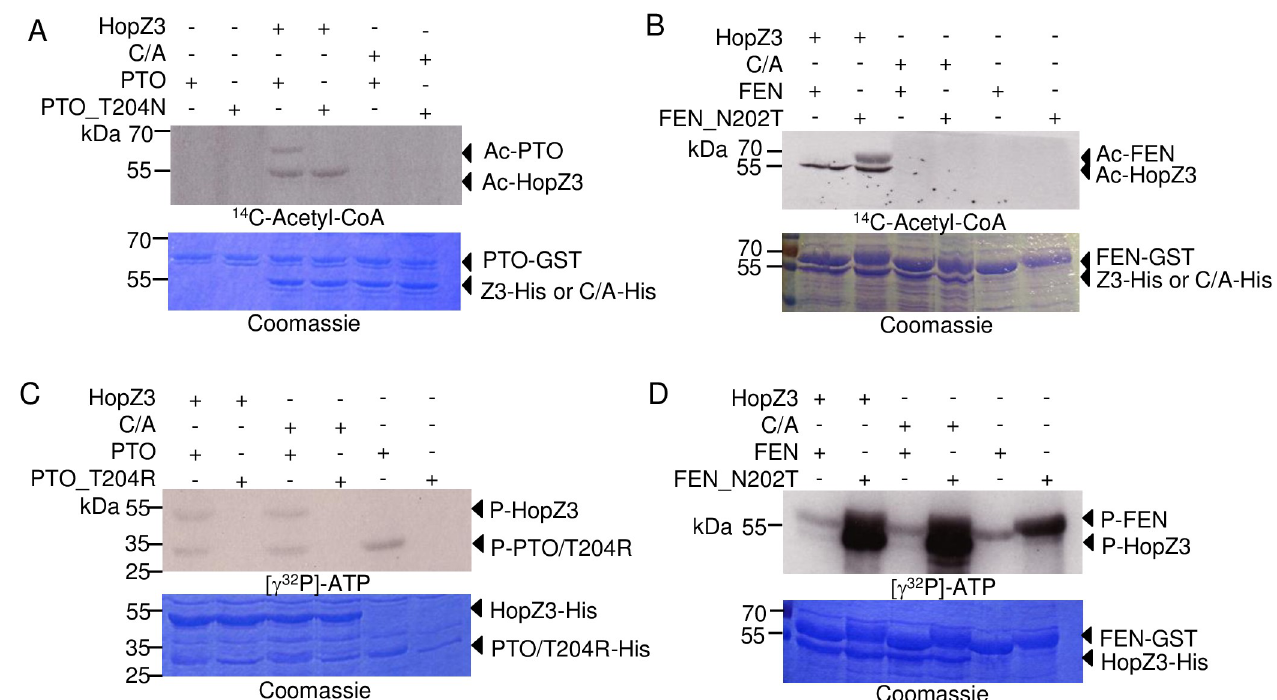
Fig 7. Substitutions in the P+1 activation loop of PTO and FEN affect their acetylation by HopZ3 and their kinase activity. Purified PTO-GST and FEN variants were incubated with HopZ3-His or HopZ3_C300A (C/A) mutant in the presence of IP6 and 14 C-acetyl-CoA (A–B) or γ 32 P-ATP (C-D). Samples were separated by SDS-PAGE and subjected to autoradiography. (A) PTO but not a T204N P+1 activation loop variant was acetylated by HopZ3. (B) The substitution of Asn202 to Thr in FEN conferred acetylation by HopZ3. (C–D) Kinase activity assay showing PTO and FEN autophosphorylation and transphosphorylation of HopZ3 and HopZ_C300A in vitro . Kinase variants with Thr (wild-type PTO and FEN_N202T) were more active than Arg or Asn variants.